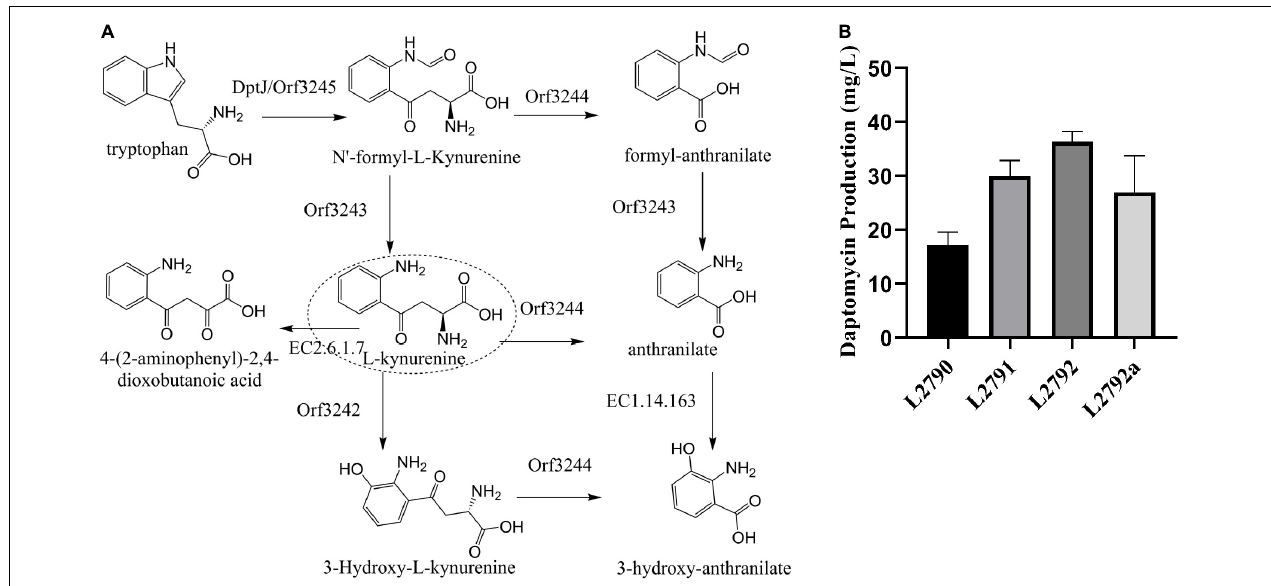
FIGURE 2 | Improving daptomycin production by enhancing Kyn precursor supply. (A) The putative L-Kyn metabolic network in strain L2790 according to the RAST Server. DptJ/Orf3245, tryptophan-2,3-dioxygenase; Orf3244, L-kynureninase; Orf3243, N (cid:48) -formyl-L-kynurenine formidase; Orf3242, oxidoreductase; EC 2.6.1.7, a putative kynureninase aminotransferase. (B) The daptomycin production of different strains obtained in a stepwise manner. The culture samples were collected at 144 h and daptomycin production was analyzed by high-performance liquid chromatography (HPLC). The fermentations were performed in triplicate. L2790, initial strain; L2791, the resultant strain by deleting orf3244 in L2790; L2792, the resultant strain by deleting orf3242 in L2791; L2792a, the resultant strain by co-overexpressing dptJ , orf3245 , orf3243 driven by ermEp * in L2792.